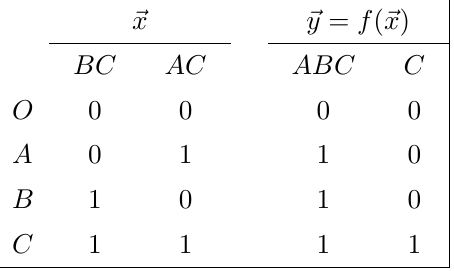
Table 1 . The unique contraction map for the strong subadditivity